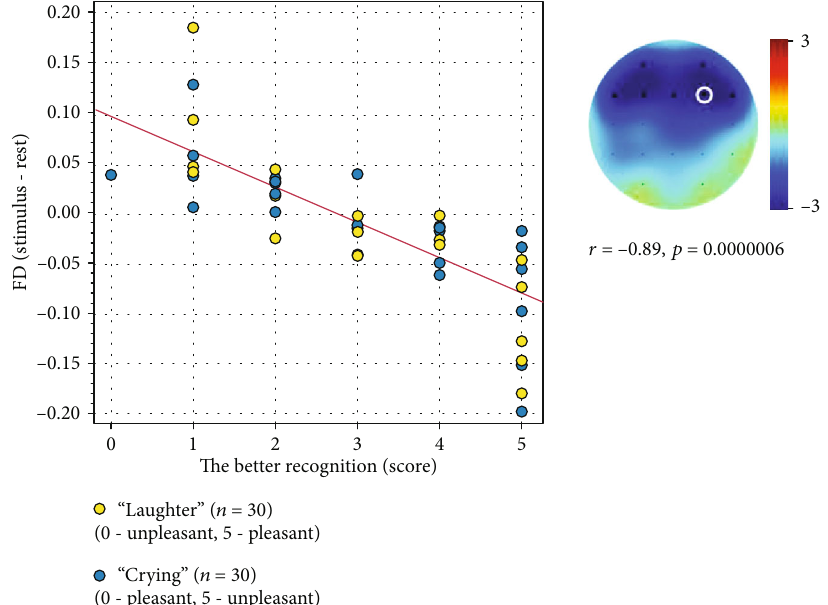
Figure 5: Results of the permutation test ’ s correlation analysis between di ff erences of FD values (the FD during rest was subtracted from crying and laughter) and assessments of these stimuli by scale (unpleasant-pleasant) uni fi ed in such a way that 0 is the incorrect recognition of the emotion, and 5 is the correct recognition of the emotion.